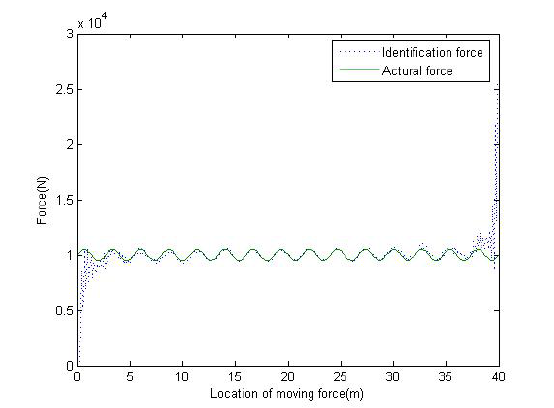
Fig. 8. Identification force comparing actual force.